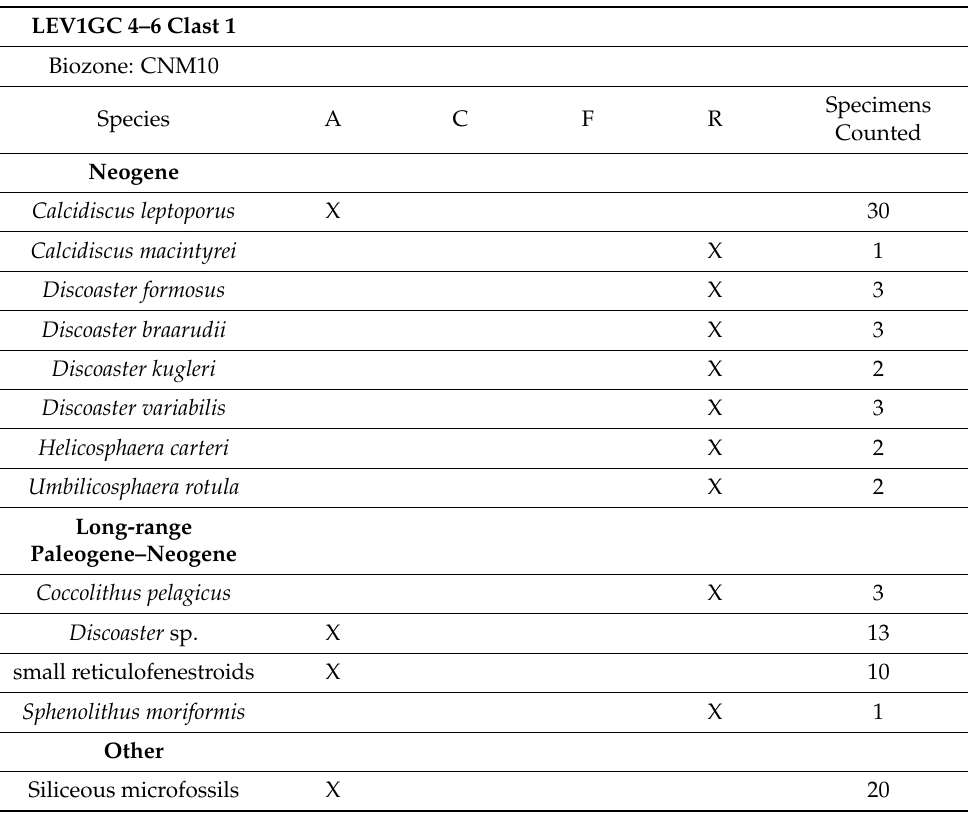
Table A7. Gelendzhik MV.